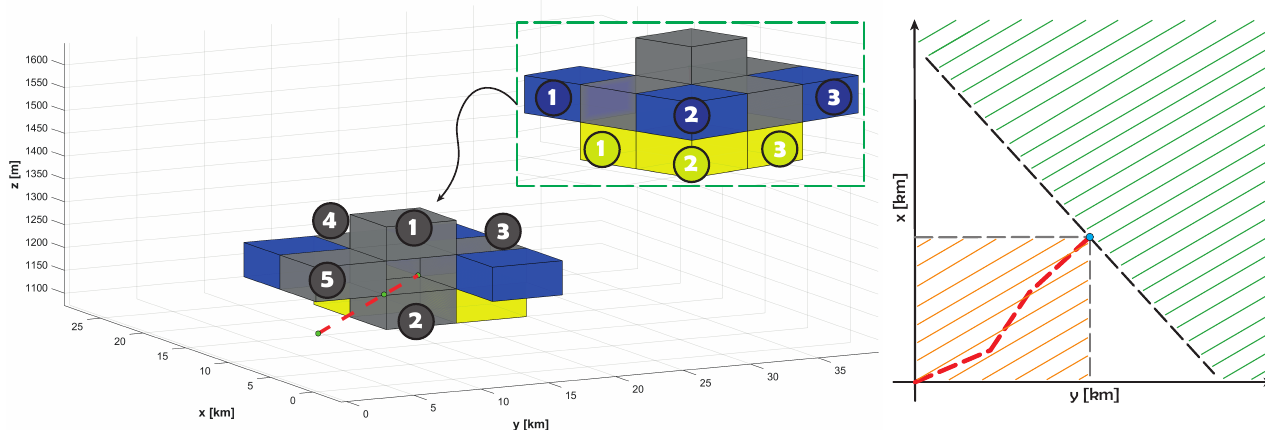
Figure 4. Examples of the possible neighbor subspaces at a point in the path ( left ); the available area in the XY plane in green and the fully forbidden zone in orange ( right